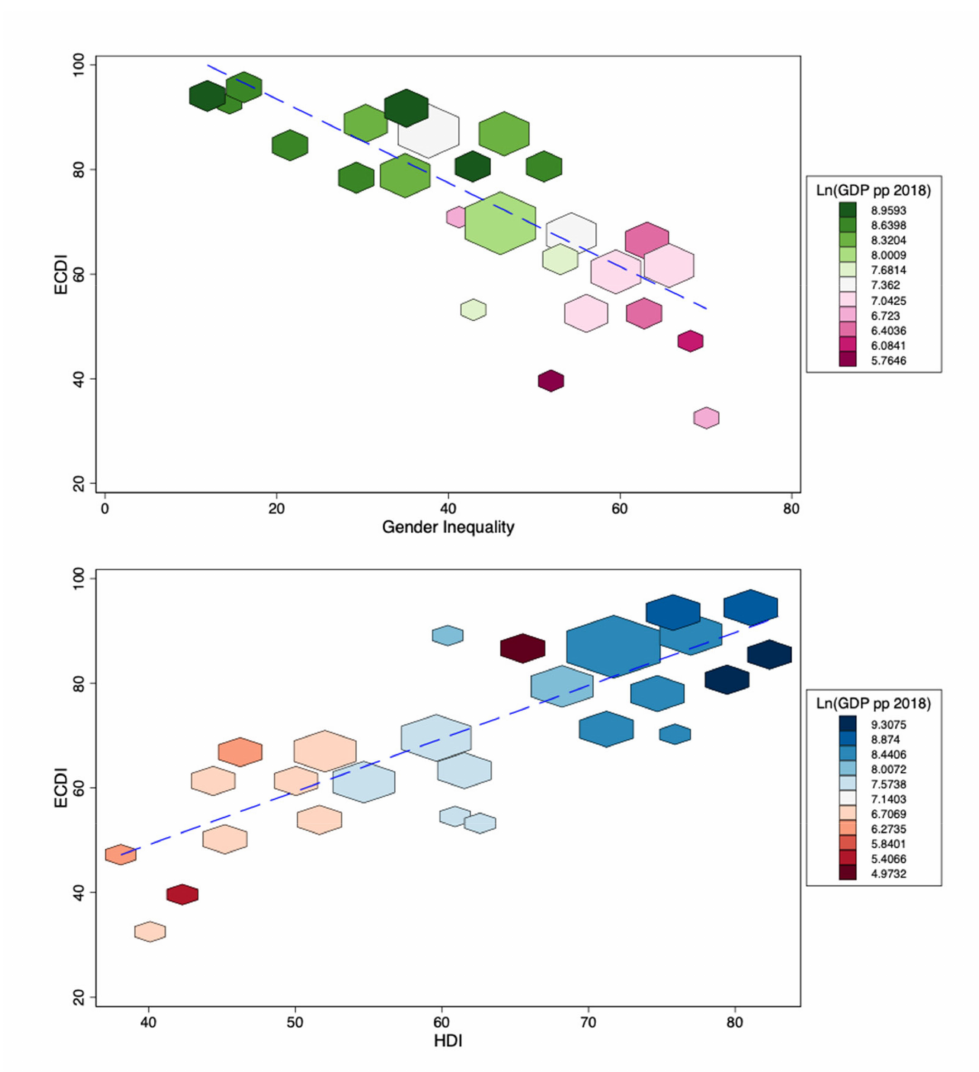
Figure 2. Human Development Index (HDI) and gender inequality rates by ECDI levels ( N = 68 LMICs) . Note: Blue dashed line represents a linear fit between the two variables. Bigger shapes indicate a higher proportion of data